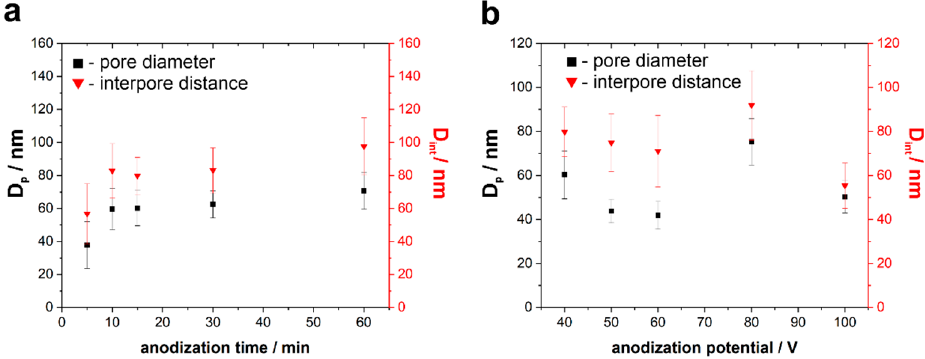
Figure 3. Pore diameter (D p ) and interpore distance (D int ) as a function of anodizing time ( a ) and anodizing potential ( b ). The electrochemical oxidation of Ti15Mo alloy was conducted in the ethylene glycol-based electrolyte at 20 °C. The error bars represent the standard deviation from at least 50 measurements from three separate samples anodized at the same conditions.